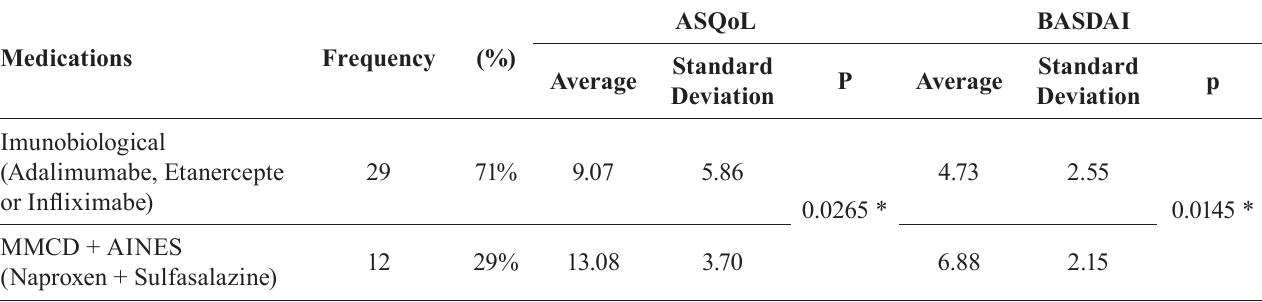
TABLE V – F requency distribution and analysis of variance for the ASQoL and BASDAI indexes, according to the use or non- use of immunobiological